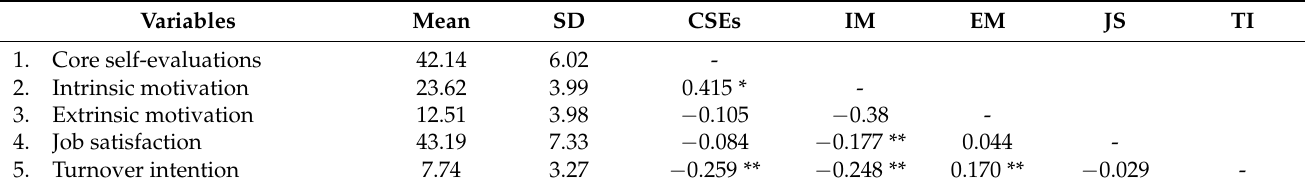
Table 3. Means, standard deviation, and correlations of all variables.